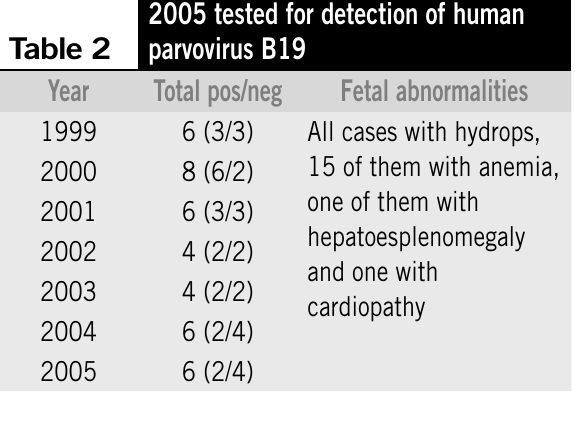
Cases of hydrops fetalis from 1999 to 2005 tested for detection of